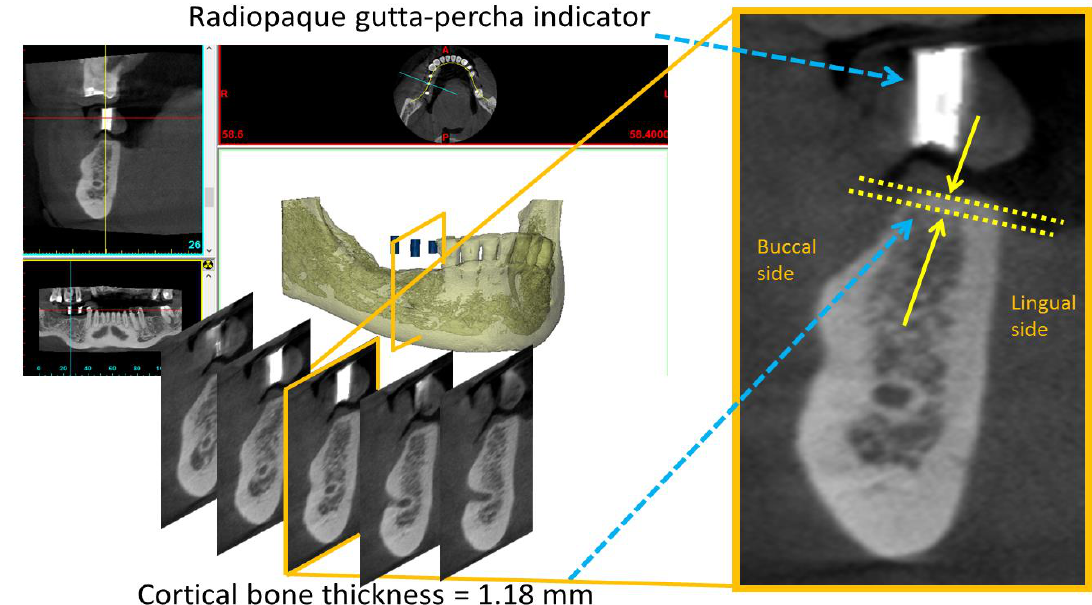
Figure 2. Measurement of cortical bone thickness, distance between the two yellow arrows, at a dental implant site.